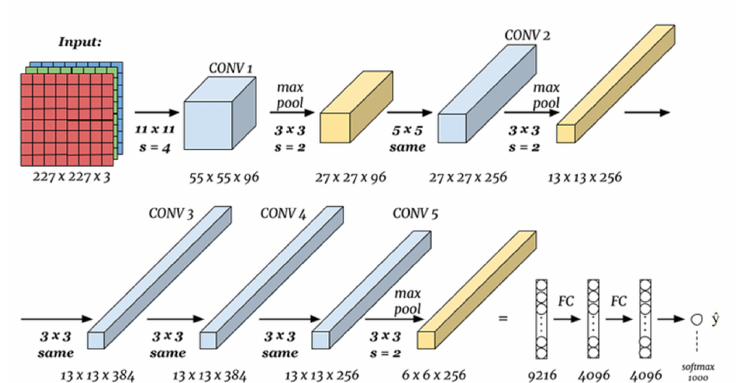
Fig. 6 AlexNet architecture